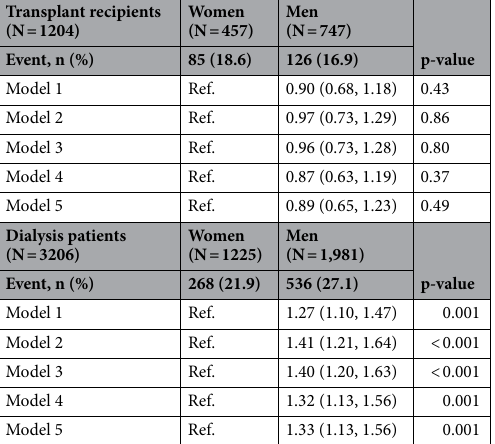
Table 2. Association of sex with 3-month mortality in kidney transplant recipients and dialysis patients with COVID-19 (presented are hazard ratios with 95% confidence intervals). Model 1: crude. Model 2: Model 1 + age (continuous), clinical frailty score (continuous). Model 3: Model 2 + the reason for COVID-19 screening (symptoms-based screening, positive COVID-19 contact or routine screening). Model 4: Model 3 + smoking (never, current, former), obesity (yes/no), hypertension (yes/no), diabetes (yes/no), heart failure (yes/no), chronic lung disease (yes/no), coronary artery disease (yes/no), and auto-immune disease (yes/no). Model 5: Model 4 + duration of kidney function replacement therapy (years) and estimated glomerular filtration rate (continuous). (p-for interaction between sex and type of kidney function replacement therapy = 0.02 in fully adjusted model for 3 month